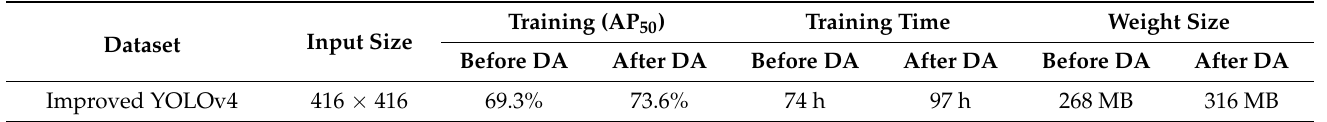
Table 3. Training accuracy before and after data augmentation (DA).